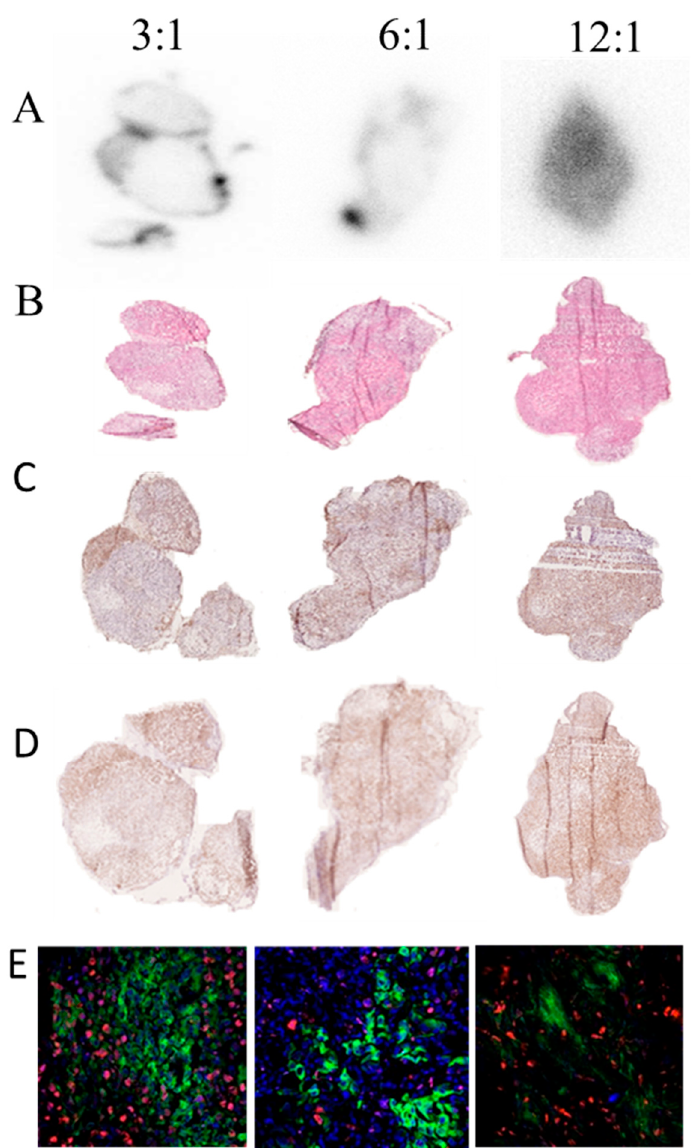
Figure 2. Digital autoradiography and immunohistochemistry of 111 In-DOTA-hu5A10 5 days after injection. ( A ) Each representative digital autoradiography image of activity uptake is individually scaled from 0 (white) to max (black) signal in that section, demonstrating that the higher the chelate-to-antibody molar ratio, the more even the activity distribution in the tumor. ( B ) The same tissue sections as in ( A ) stained with hematoxylin and eosin, demonstrating the tumor histology. ( C ) Adjacent sections illustrating the distribution of immunohistochemically labelled Ki-67-positive proliferating cells. ( D ) Adjacent sections to ( C ), demonstrating the distribution of immunohistochemically labelled PSA-positive cells. ( E ) Immunofluorescence double labeling, illustrating the distributional relation of radionuclide uptake primarily in viable tumor regions with PSA-expressing cells (green) and Ki67-positive cells (red), rather than in necrotic regions.